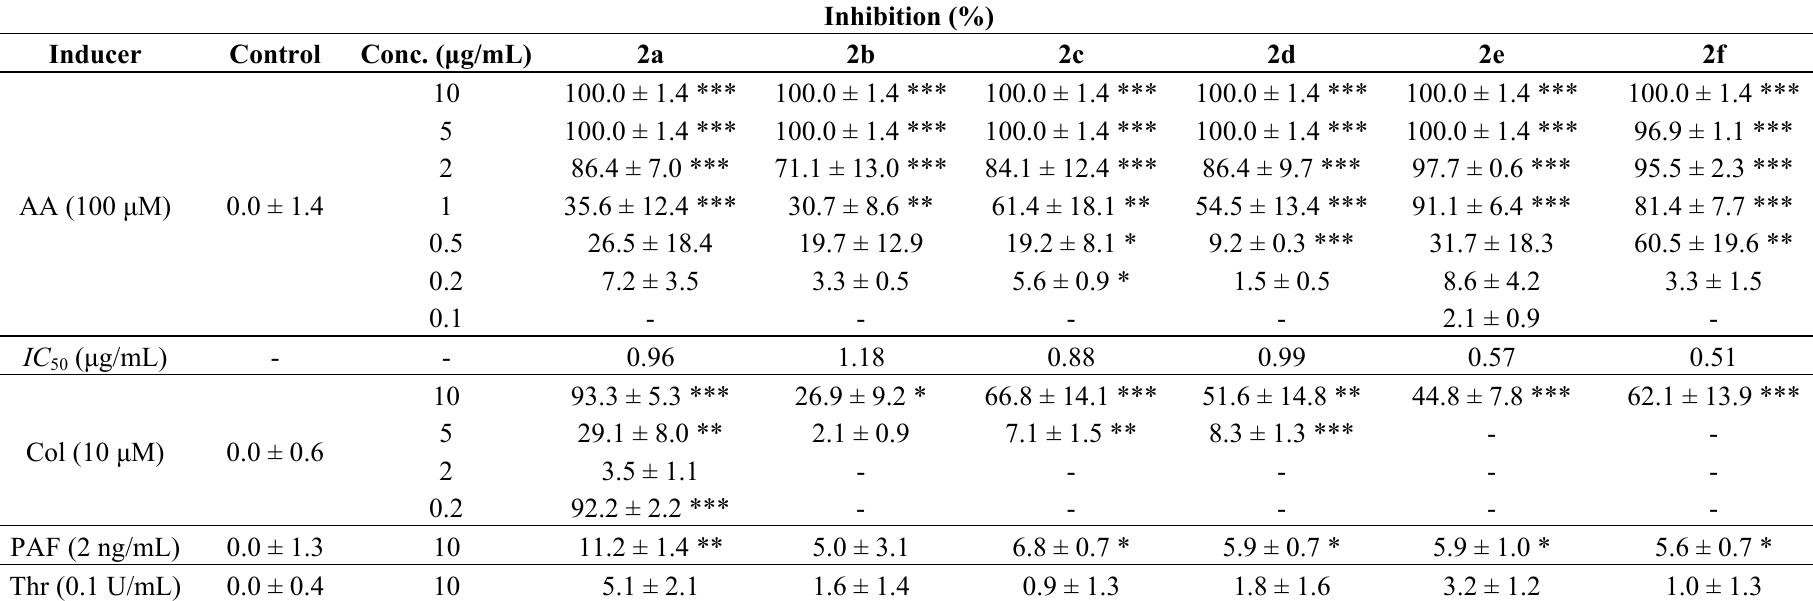
Table 9. Antiplatelet activity of [ n ]-dehydroshogaols 2a – f